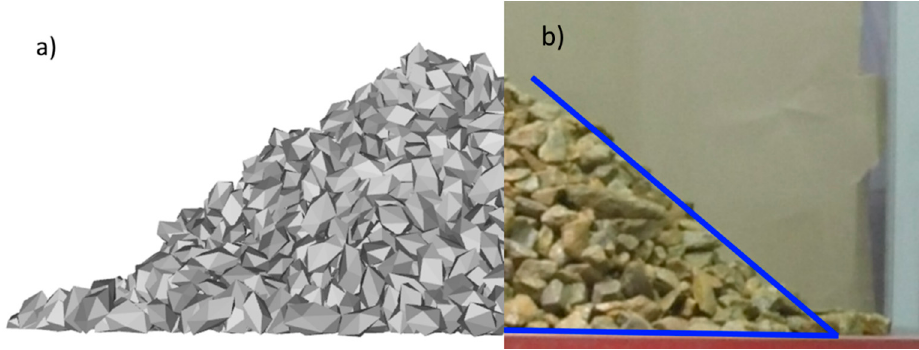
Figure 5. Friction coefficient “ore-ore” measurement test. ( a ) Simulated experiment, ( b ) Laboratory experiment.